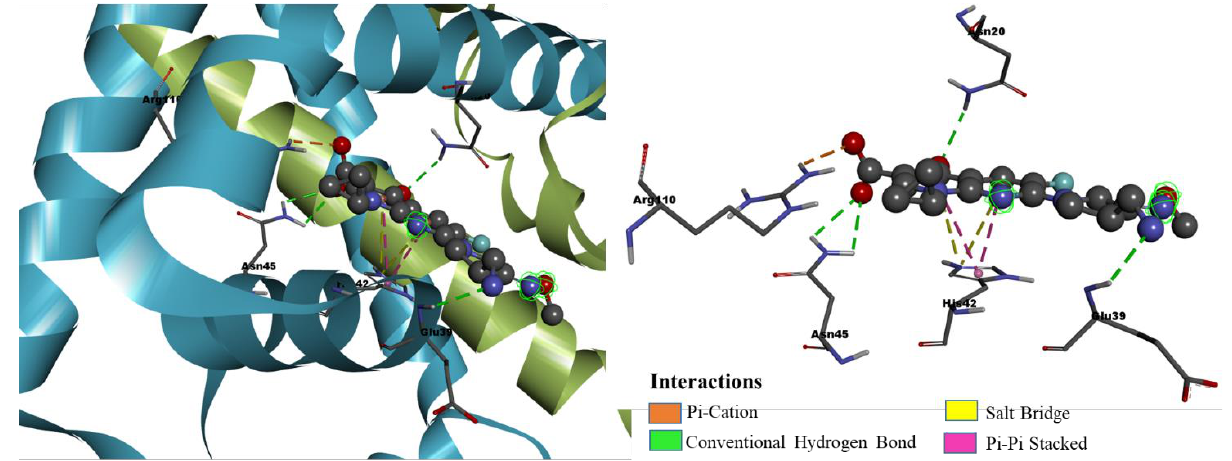
Figure 3. Binding mode conformation and molecular interactions of methicillin in the active site of S. epidermidis TcaR. The left and right figures represent the molecular interactions in 3D and 2D, respectively. The methicillin is shown in the ball-stick model, and the key interacting residues are shown as grey sticks.